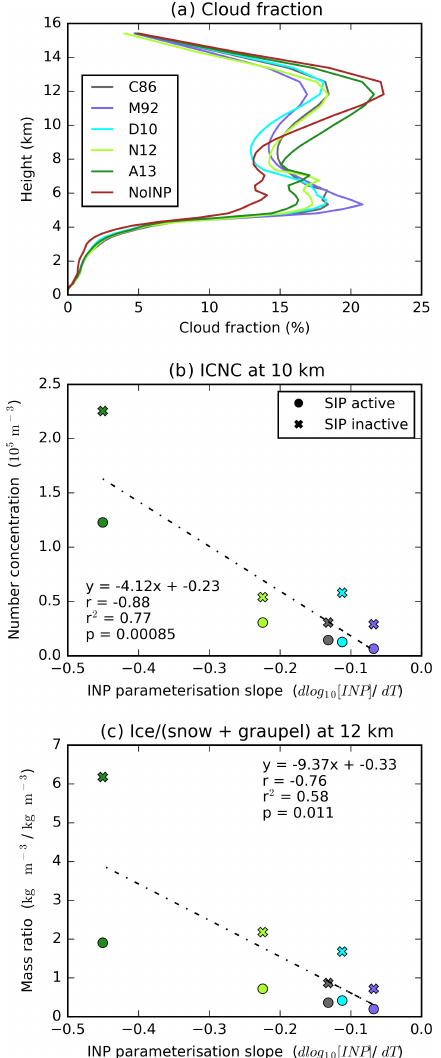
Figure 7. Cloud fraction and INP parameterisation slope. Domain- mean cloud fraction profile (a) , INP parameterisation slope plotted against the ice crystal number concentration at 10km (b) , and mass ratio of ice crystals to snow and graupel at 12km (c) . Also shown in panels (b) and (c) are the respective regression lines ( n = 10) and associated statistical descriptors.